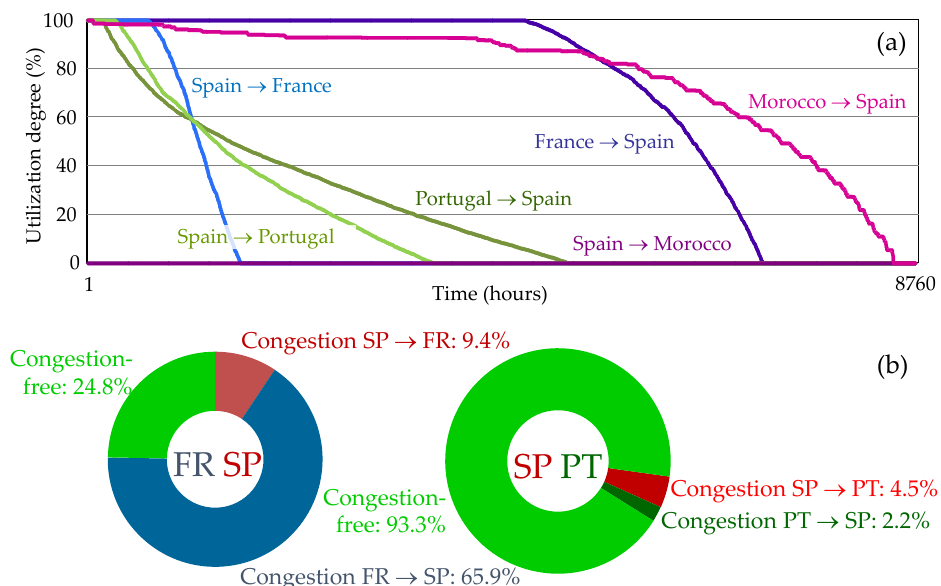
Figure 2. ( a ) Hourly load duration curves of the degrees of utilization of the commercial interchange capacities of the Spanish cross-border interconnections and ( b ) annual percentage of days with and without congestion in the interconnections France-Spain and Spain-Portugal in 2017.